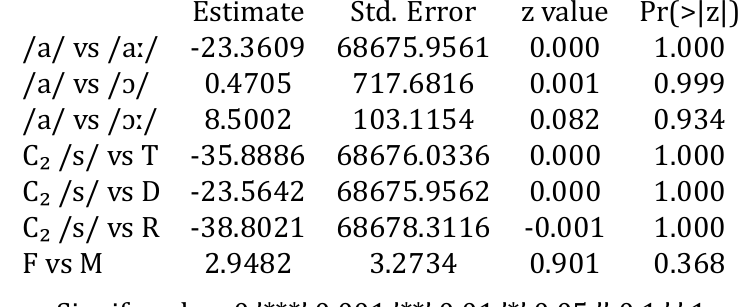
Table A.10: Post-aspiration duration (ms) of C₁ /s/ as a dependent variable